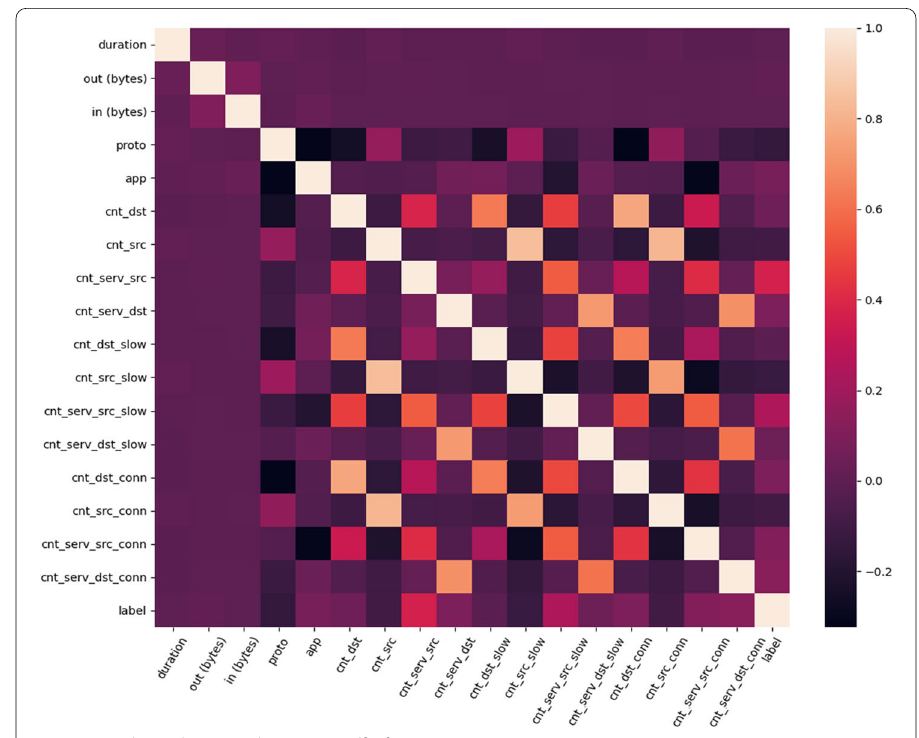
Fig. 4 Correlation heatmap between traffic